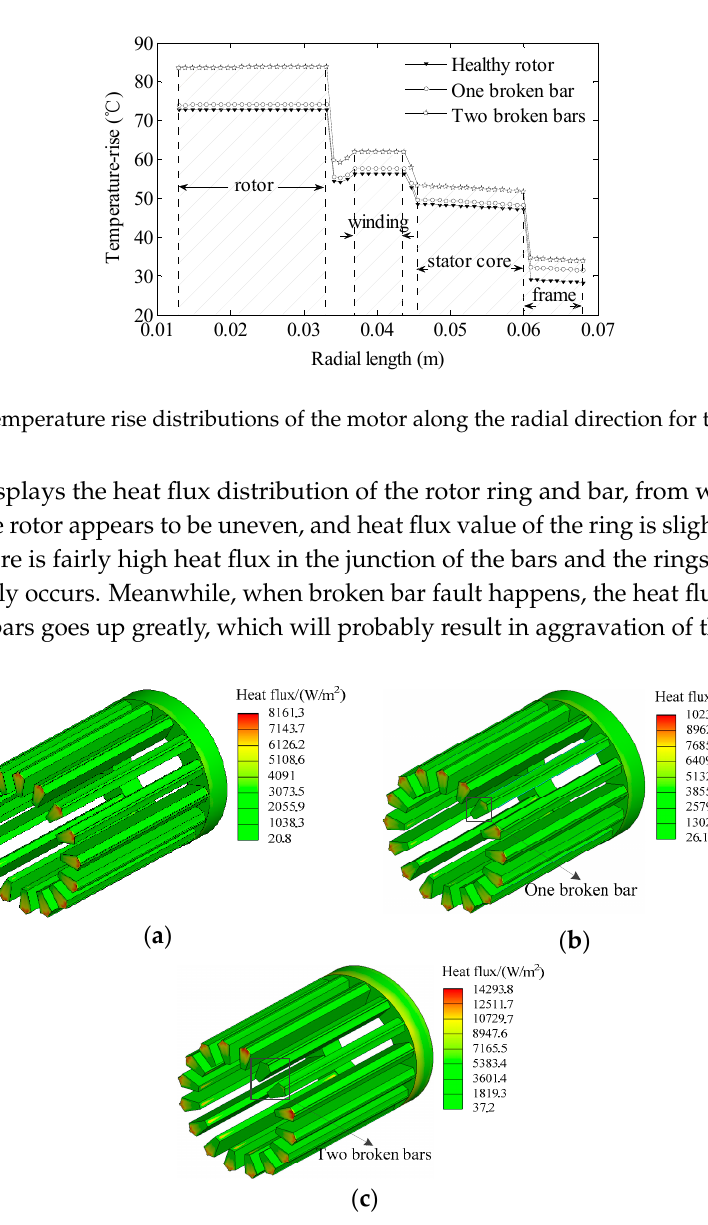
Figure 22. Heat flux distribution of the rotor: ( a ) Healthy motor cage; ( b ) One-broken-bar fault; ( c ) Continuous two-broken-bars.